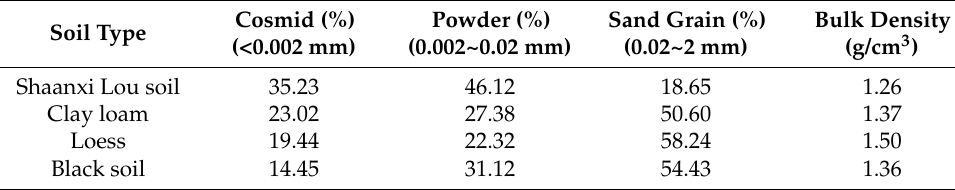
Table 1. Physical properties of four different texture soils.